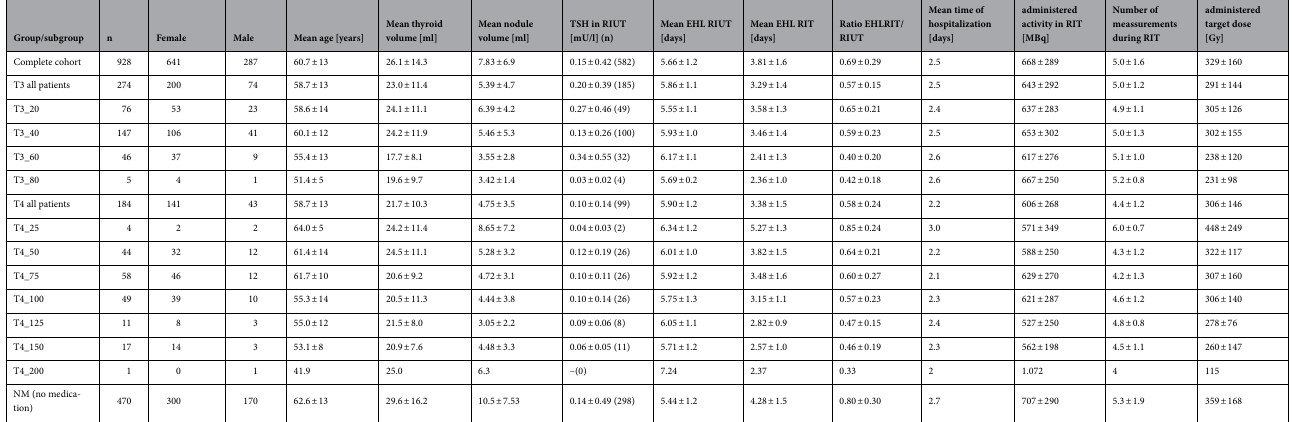
Table 1. Comparison of the investigated subgroups regarding demographic and biokinetics